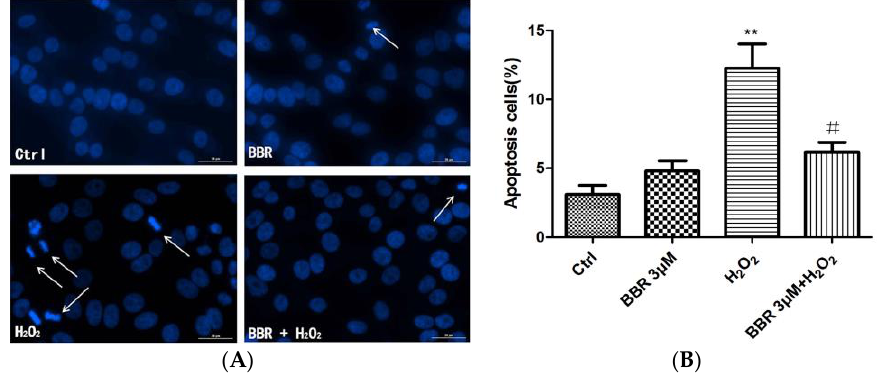
Figure 2. BBR attenuated H 2 O 2 -induced apoptosis in D407 cells. Apoptosis of D407 cells was detected by Hoechst 33342 staining and visualized by fluorescence microscopy. The number of apoptotic nuclei with condensed chromatin was counted from the photomicrographs and presented as a percentage of the total number of nuclei. ** indicates p < 0.01 versus the control group; # indicates p < 0.05 versus the H 2 O 2 -treated group were considered significantly different.